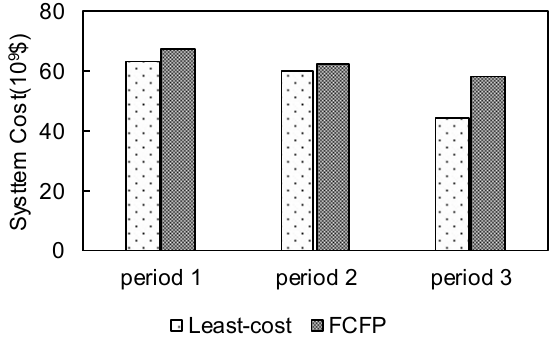
Figure 9. Comparison of system cost from FCFP and Least-system-cost models.